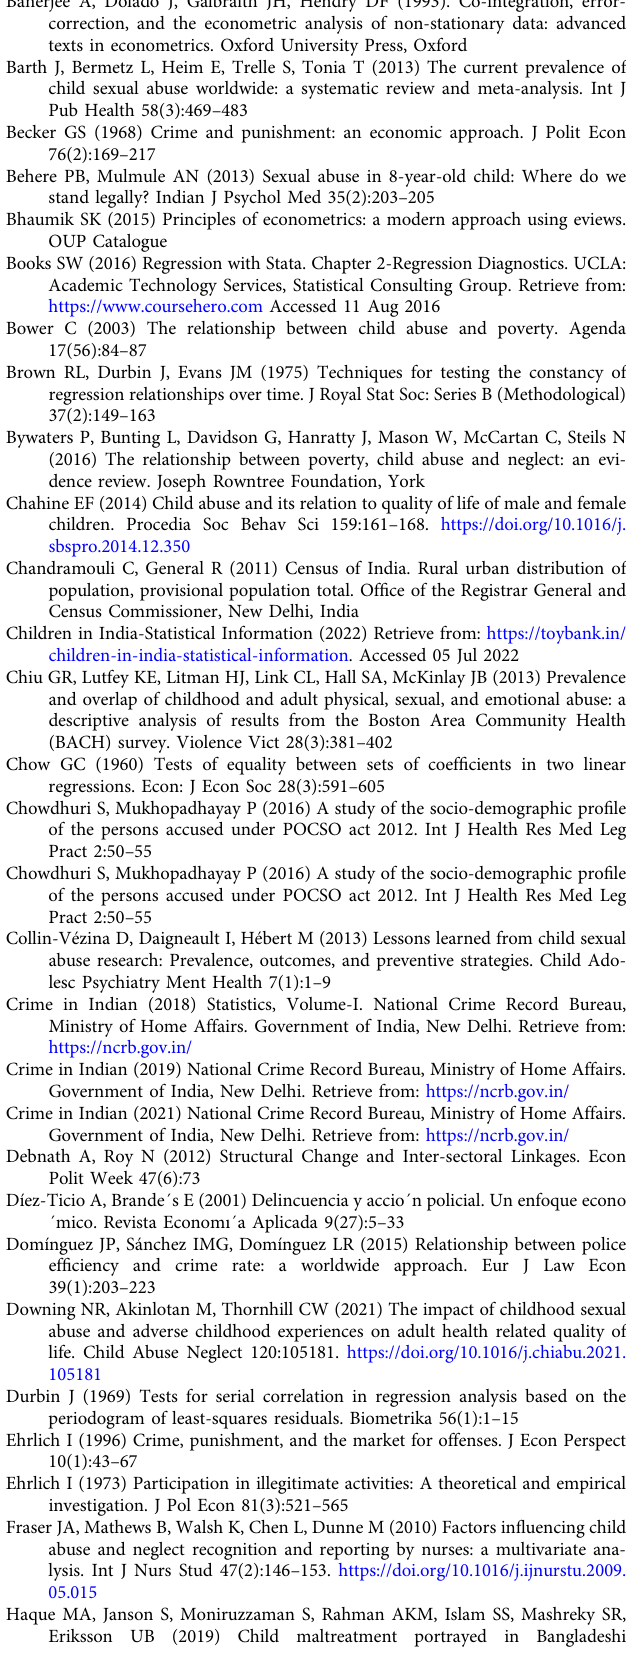
Table 10 Physical Quality of Life Index across Indian states and India.